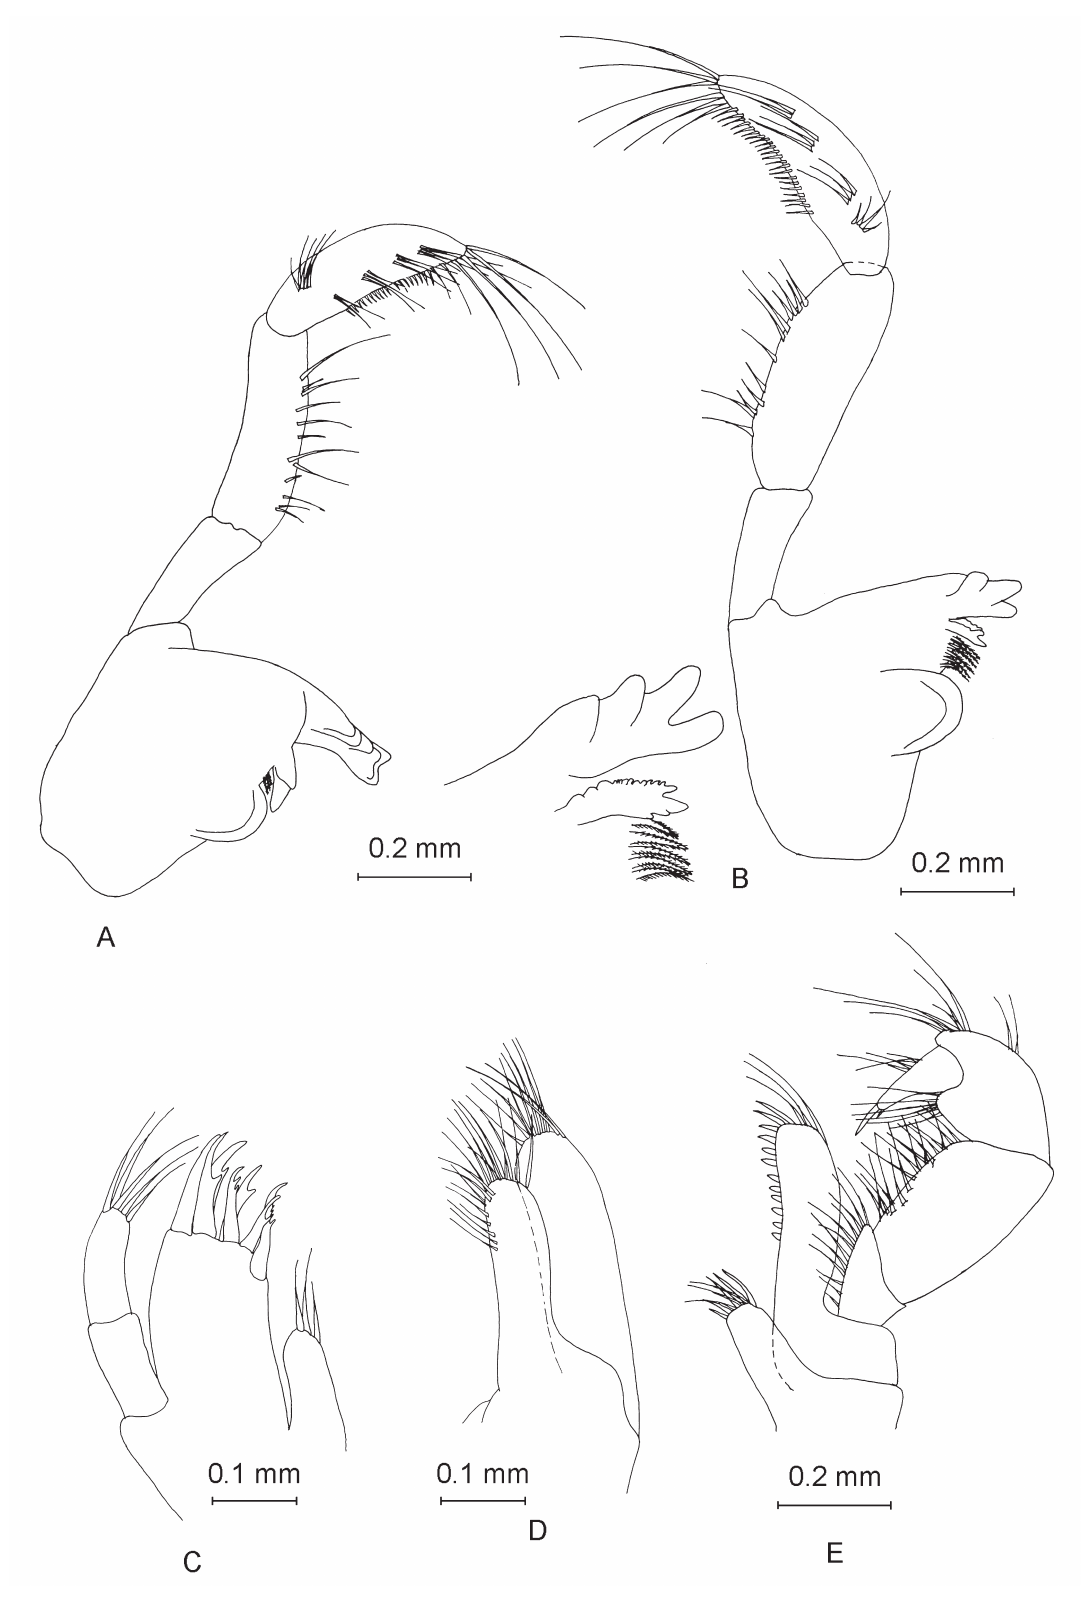
Fig. 10. Female mouthparts. A . Left mandible. B . Right mandible. C . Maxilla I. D . Maxilla II. E .